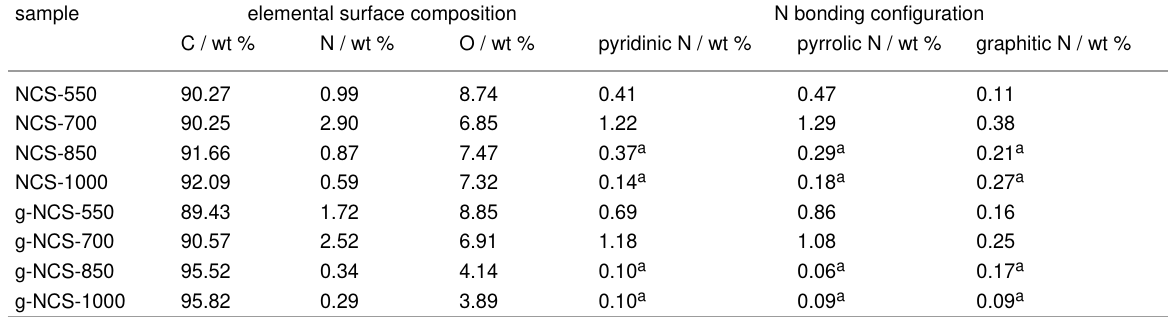
Table 2: Elemental surface composition and share of different N bonding configurations determined by XPS measurements. sample